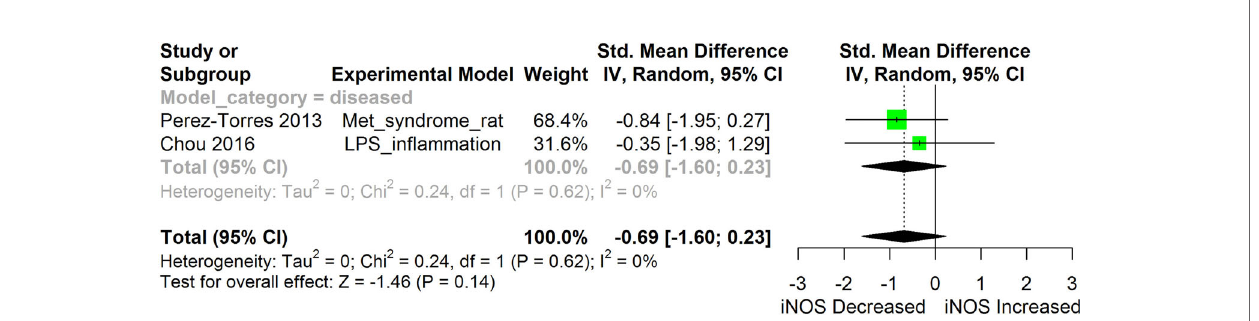
FIGURE 11 | Meta-analysis and forest plot of the effect of HS administration on iNOS. The meta-analysis was sub-grouped by health status (i.e diseased or healthy state). The standardized mean difference (SMD), which is an estimate of the effect size, is presented as a square on the forest plot, for each study and as a diamond for the pooled estimate of each subgroup or overall studies. The overall pooled SMD for all included studies is shown in the bottom section of the forest plot. SMD data points that are lower than zero signify that treatments with HS lowered the level of the biomarker while those greater than zero signify that HS treatment causes an increase in the levels of the biomarker. The statistical signi fi cance of the pooled estimate is indicated by the Z test of signi fi cance. LPS, Lipopolysaccharide;